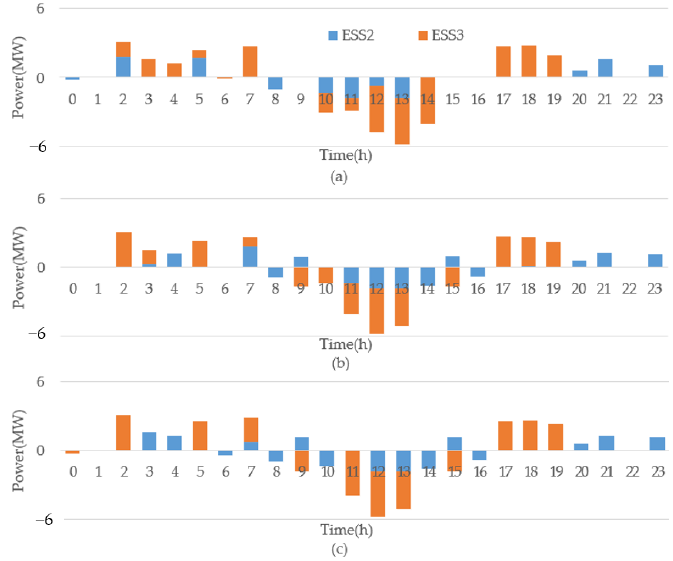
Figure 13. ED results of the ESSs ( a )Result of 1st ED ( b ) Result of 2nd ED (c) Result of 3rd ED.